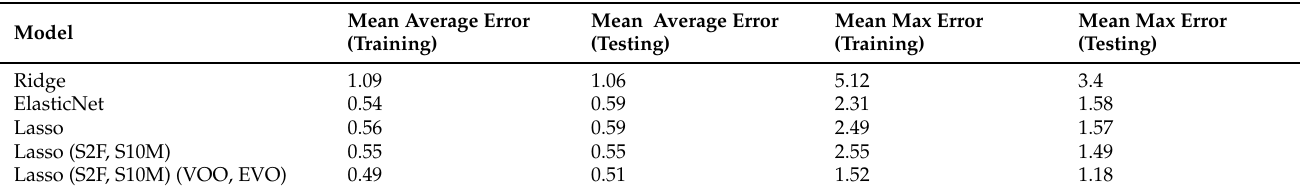
Table 2. Results obtained. for the prediction of fruity aroma. The final model structure selected was the fourth row (Lasso S2F,